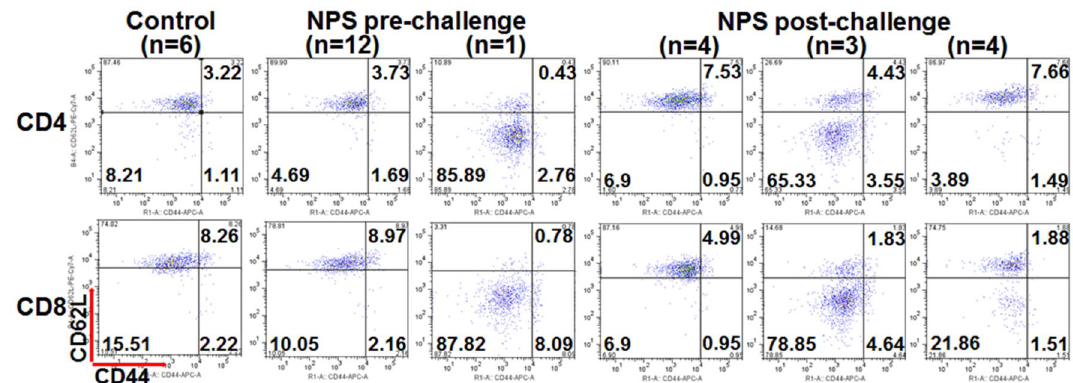
Figure 4. Various patterns of memory T cell responses after the second live tumor challenge. After NPS treatment mice with tumor free over 7 weeks (NPS, n = 13) or naïve control mice (Control, n = 6) were challenged subcutaneously with 0.5 × 10 6 Pan02 cells. Blood was collected 2 days prior to challenge (pre-challenge) or 9 days after challenge (post-challenge). One representative flow cytometric graph for each pattern was shown here. ( n = 6, 12 . . . ): numbers indicate how many animals shared the same pattern.